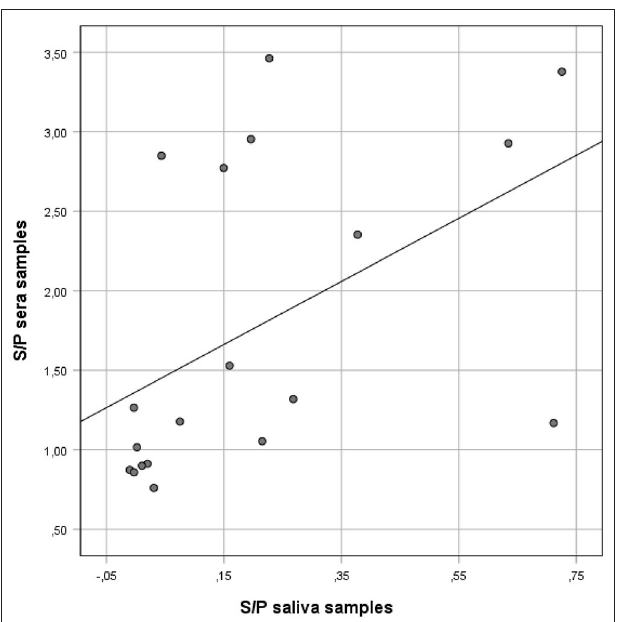
FIGURE 1 | Correlation between anti- Salmonella ELISA IgG S/P ratio values of individual serum and matching S/P ratio saliva samples collected from finisher pigs. Salmonella IgG was detected on saliva and serum samples using a commercial ELISA kit validated for serum and meat juice.